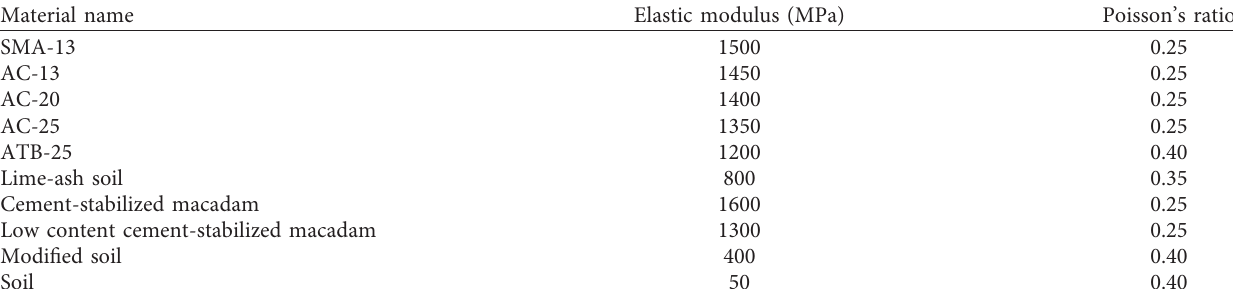
Table 1: Relevant parameters of various pavement materials.